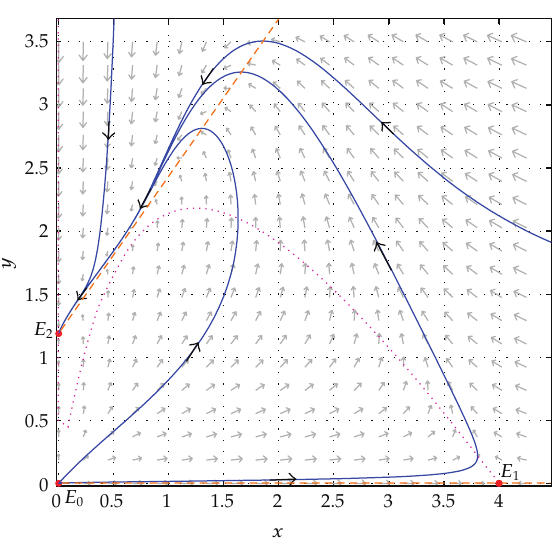
Figure 2: The phase portraits of model (cid:4) 1.3 (cid:5) . The parameters are taken as a (cid:6) 2 , b (cid:6) 0 . 25 , c (cid:6) 0 . 875 , e (cid:6) 1 , m (cid:6) 0 . 95 , and n (cid:6) 0 . 7 , f (cid:6) 0 . 8. In this case, E 0 (cid:6) (cid:4) 0 , 0 (cid:5) is a nodal source, E 1 (cid:6) (cid:4) 4 , 0 (cid:5) is a saddle point. The boundary equilibria E 2 (cid:6) (cid:4) 0 , 1 . 1875 (cid:5) is globally asymptotically stable. The dashed curve is the x -nullcline f (cid:4) x,y (cid:5) (cid:6) 0, and the dotted curve is the y -nullcline g (cid:4) x,y (cid:5) (cid:6)